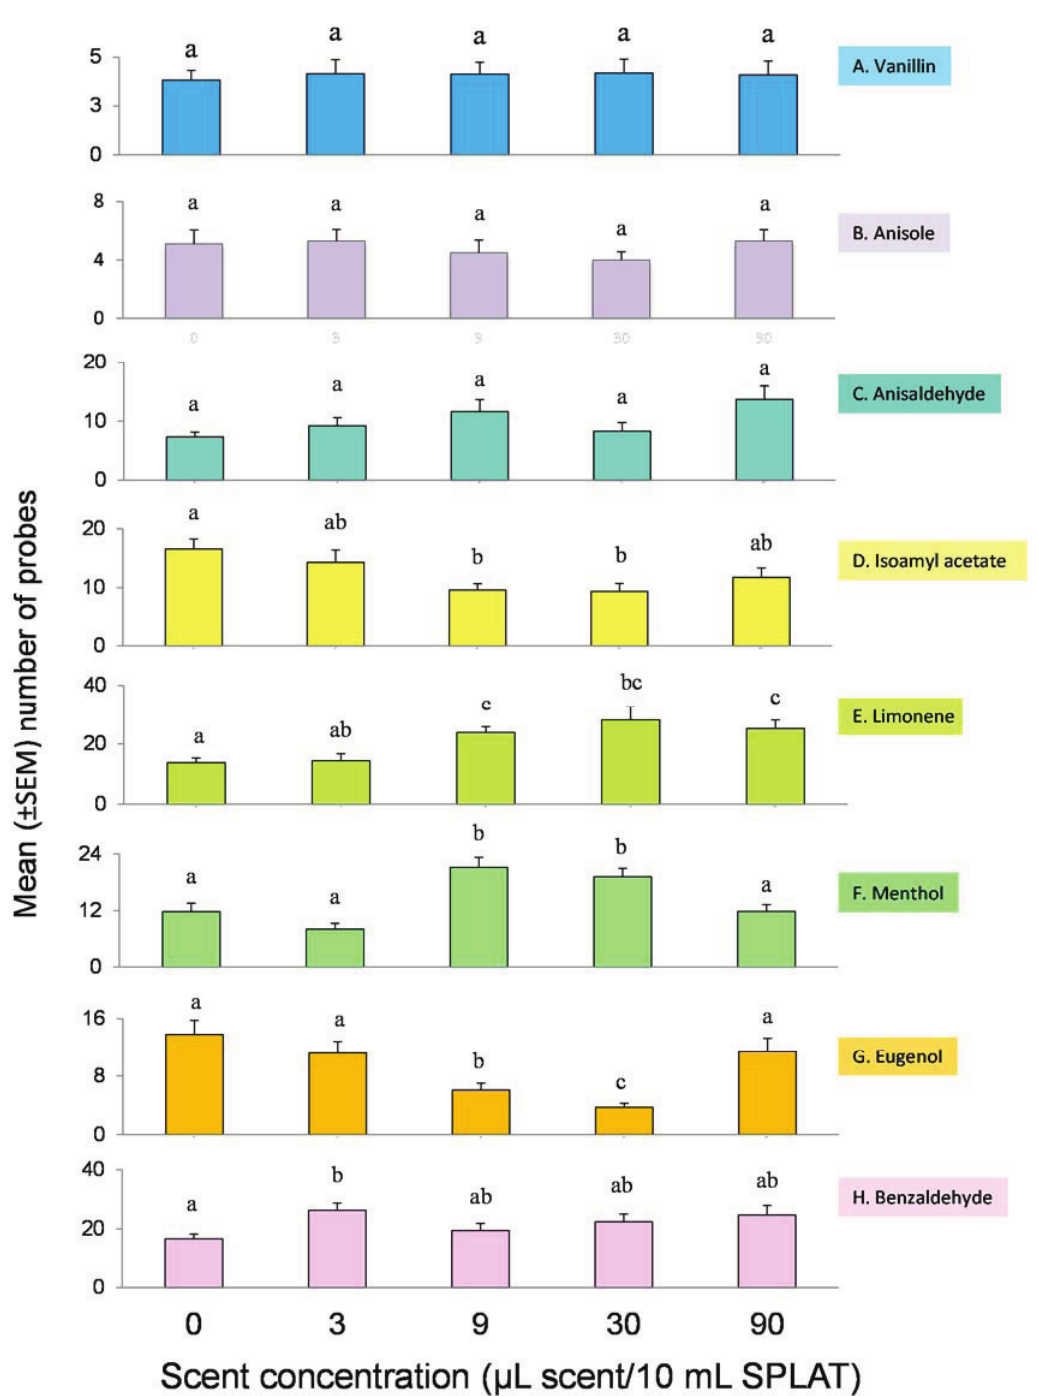
Figure 3. Innate probing responses of psyllids to test compounds at different